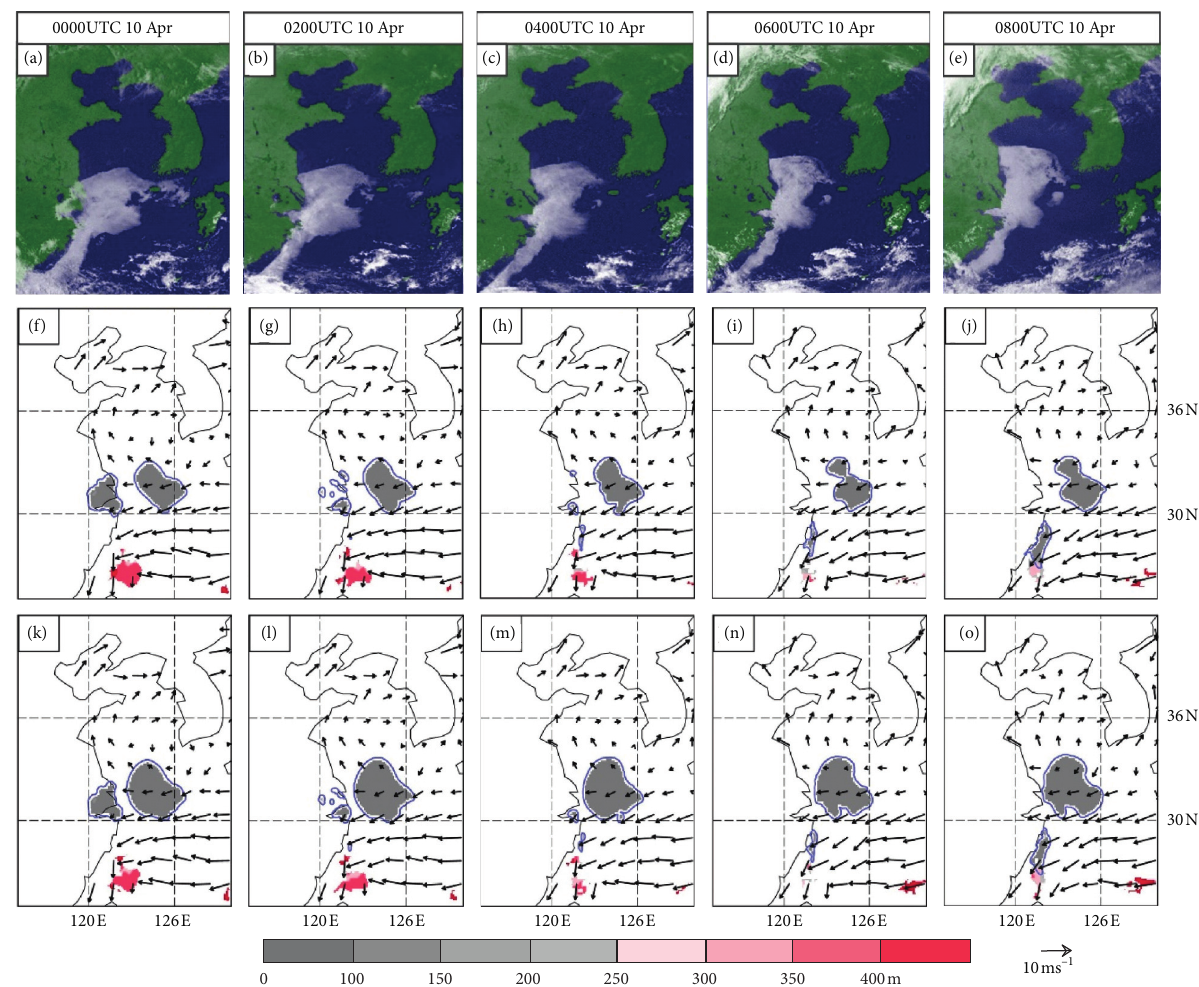
Figure 12: Comparison between the forecasted and observed sea fog areas (upper row; MTSAT visible imageries) for Case-B. The middle and lower rows show the results of Exp-B_CV5 and Exp-B_CV6, respectively. Fog depth is shown by shadings, and surface winds are displayed by